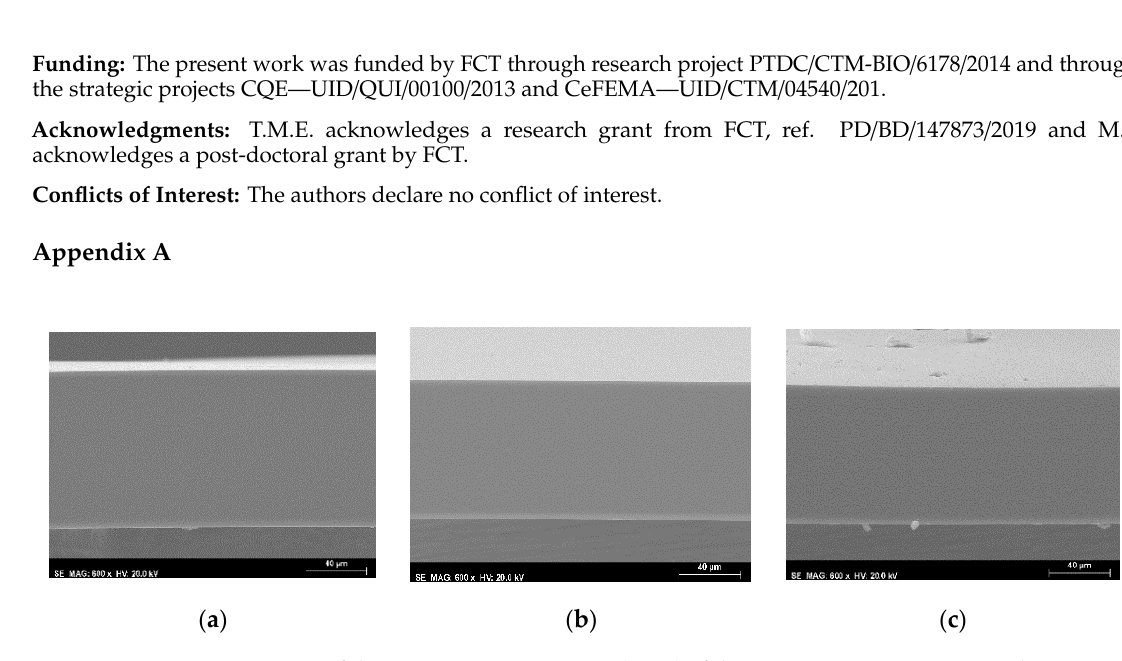
Figure A1. SEM images of the cross-section structures (600×) of the nonporous symmetric membranes from group 1: ( a ) PU0, ( b ) PU10, and ( c ) PU15.